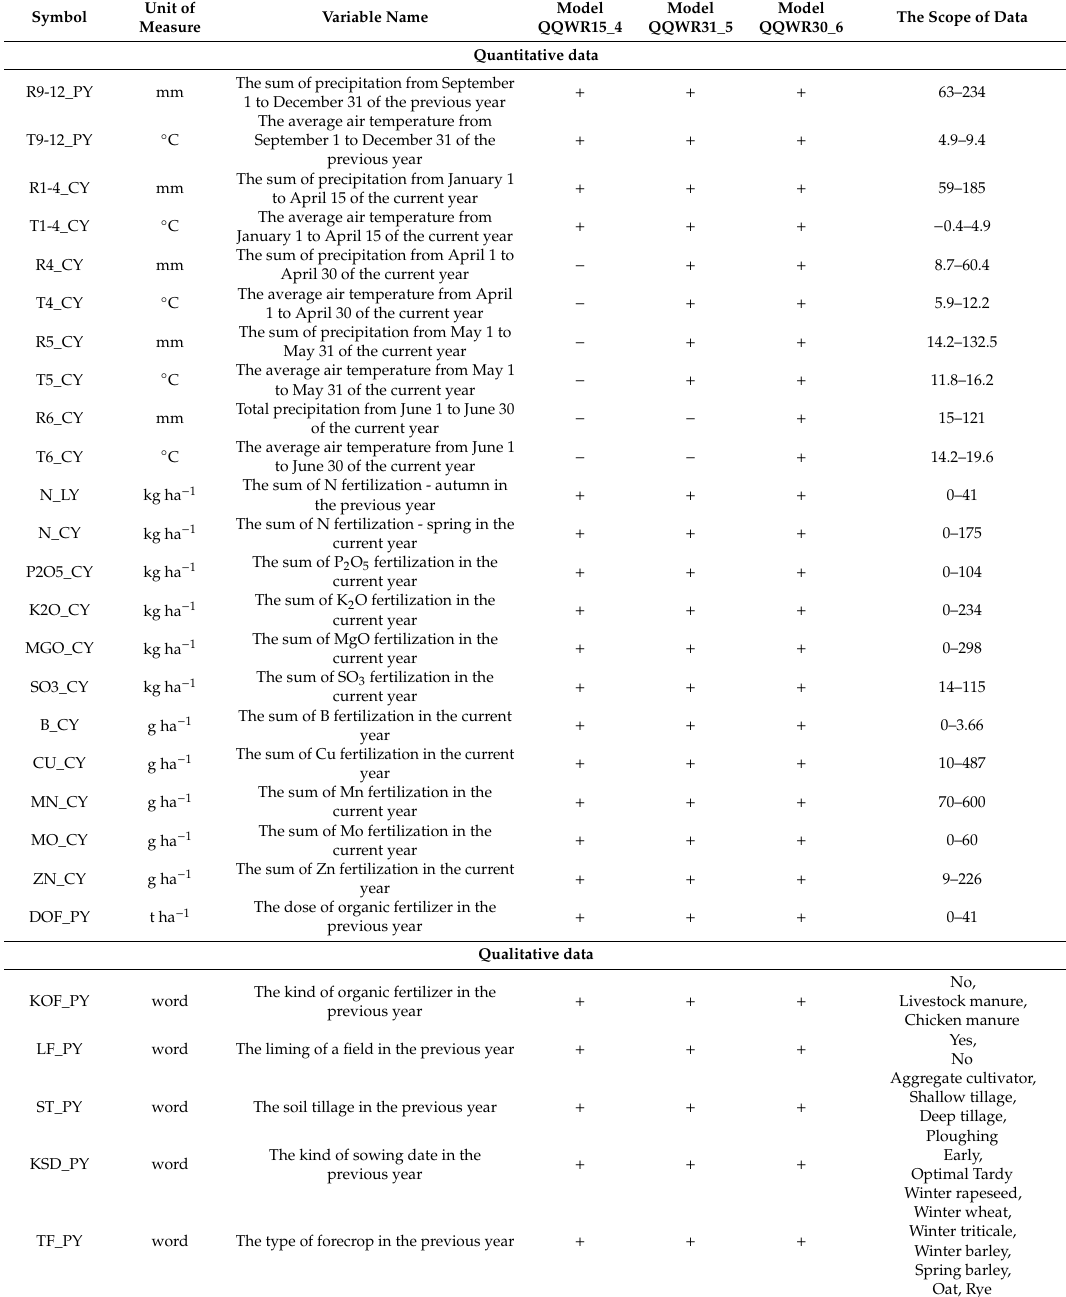
Table 2. Data structure in the neural prediction